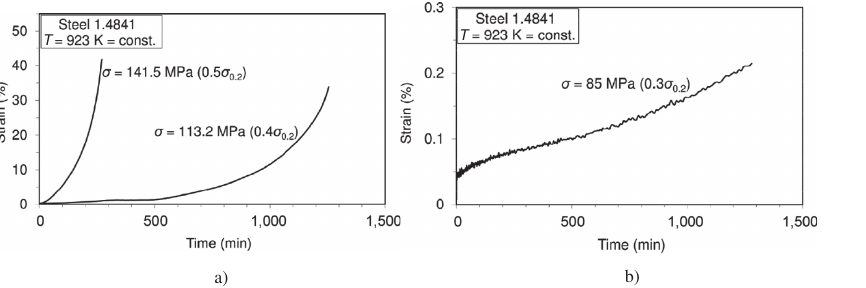
Figure 5: Creep behaviour of steel 1.4841 at a temperature of 923 K. (a) Stress level of 141.5 and 113.2 MPa and (b) stress level of 85 MPa.